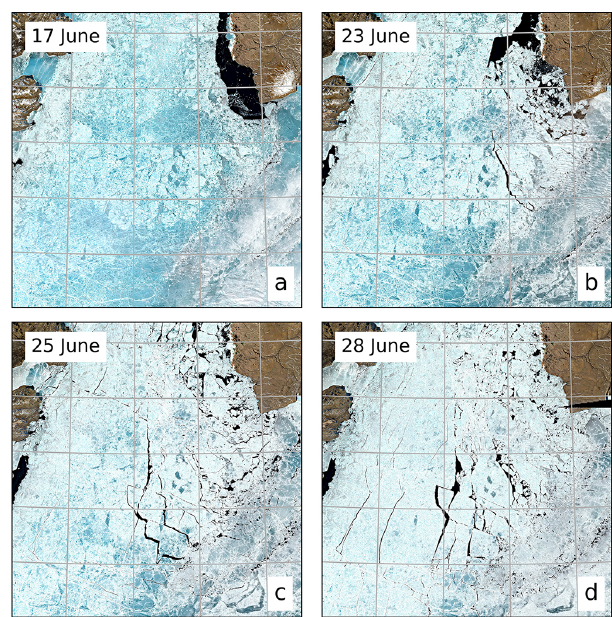
Figure 13. The Sentinel-2 images showing the fracturing propaga- tion in the central part of the ice bridge at the end of June 2020.